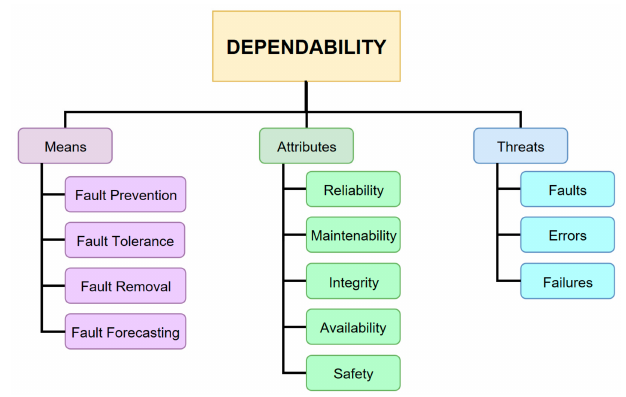
Figure 4. Dependability